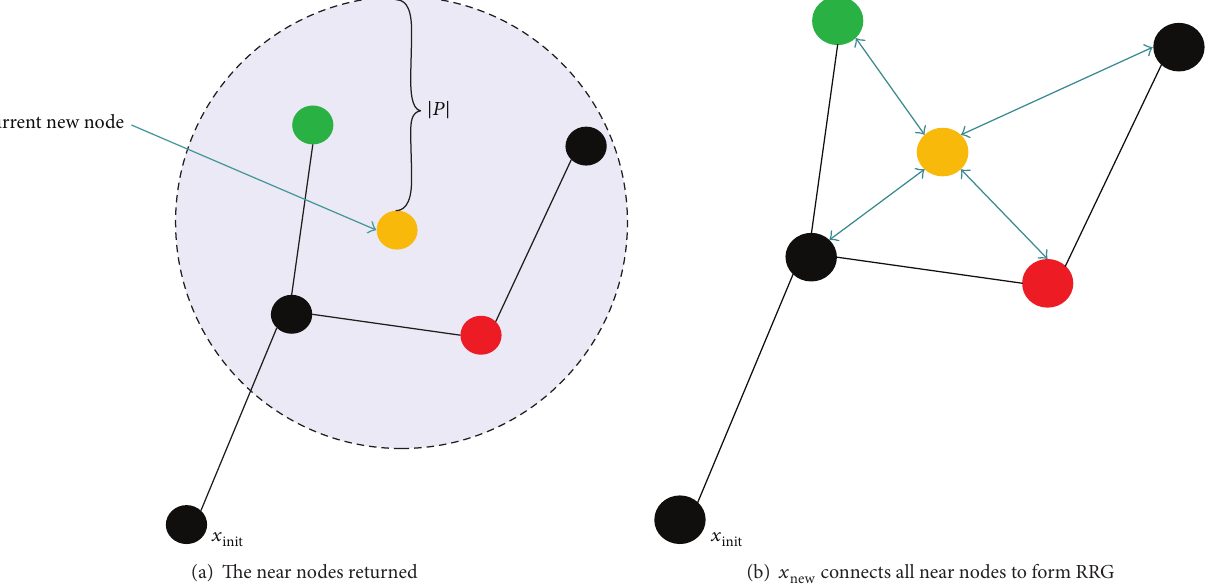
Figure 9: Typical operation of